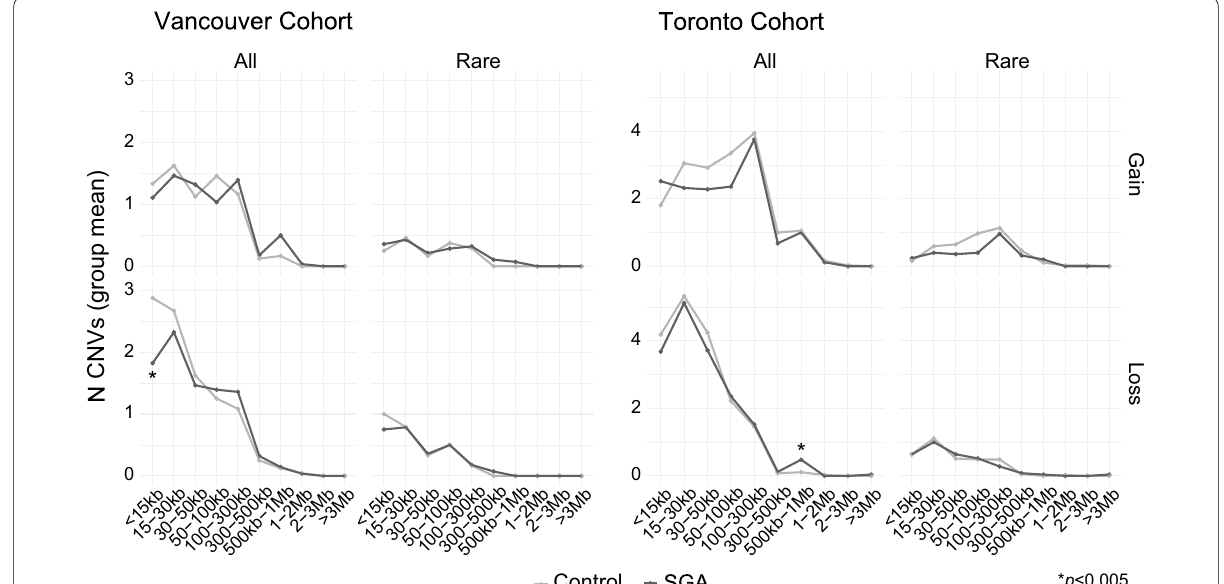
Fig. 2 Sizes of placental CNVs from control and SGA pregnancies. Plots depict the mean number of CNVs per study group at different size bins in the Vancouver and Toronto cohorts, in all CNVs or exclusively rare CNVs, and separated by gains and losses. Overall, there is no consistent difference in the sizes of CNVs between SGA and control placentas. p ‑values calculated by Mann–Whitney